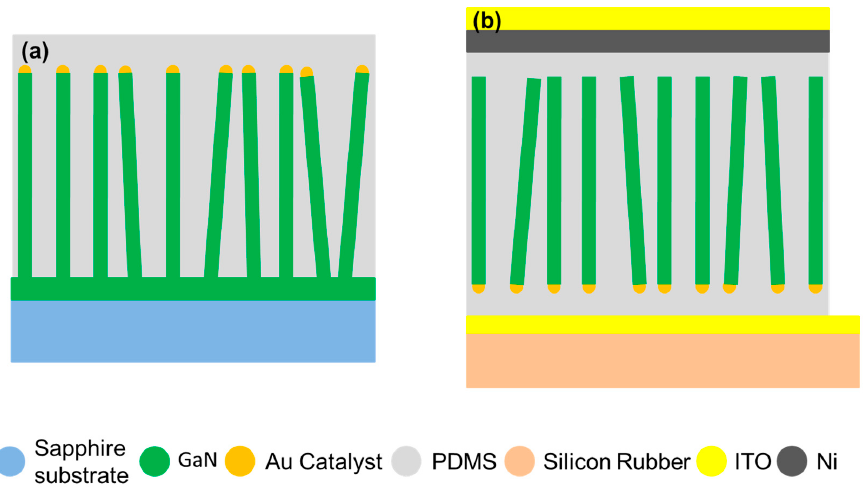
Figure 1. Schematic illustration of GaN NWs based piezoelectric nanogenerator (PNG) ( a ) c-axis GaN NWs after polydimethylsiloxane (PDMS) deposition on sapphire substrate; and, ( b ) transfer of PDMS matrix embedded with c-axis GaN NWs on Si-rubber substrate, NiO deposition and ITO electrode formation on complete device.